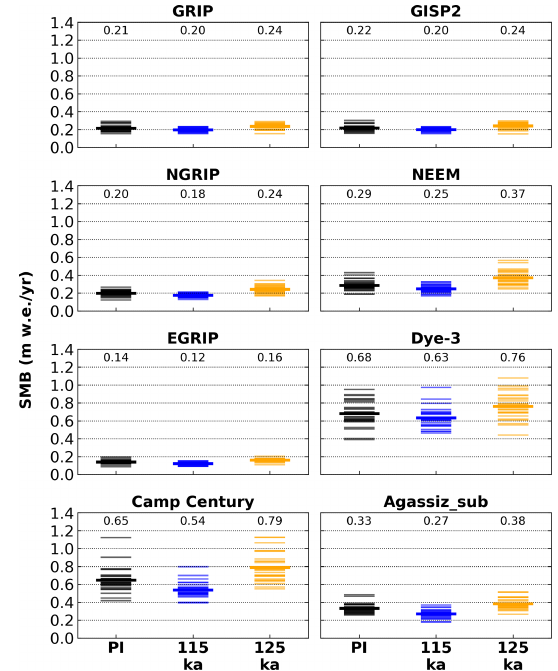
Figure A3. Annual SMB at Greenland ice core locations simulated by the MAR climate model for three time slices. Individual model years (thin lines) and the mean (bold lines, numerical values on top of columns) are